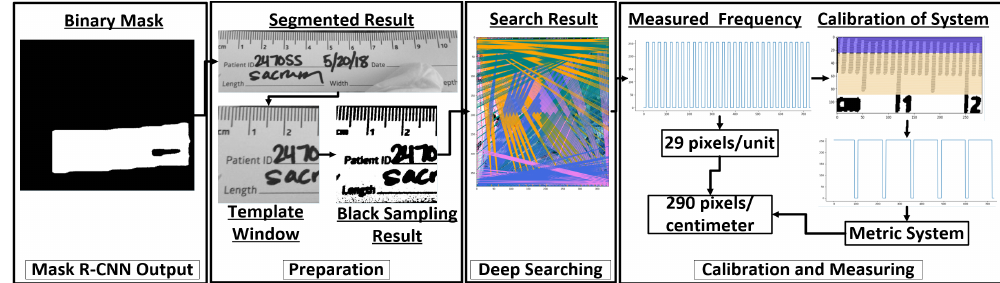
Figure 2. (Overview Procedure) Integration of Mask Region proposal based Convolutional Neural Network (R-CNN) output with scale calibration system for calibrating an